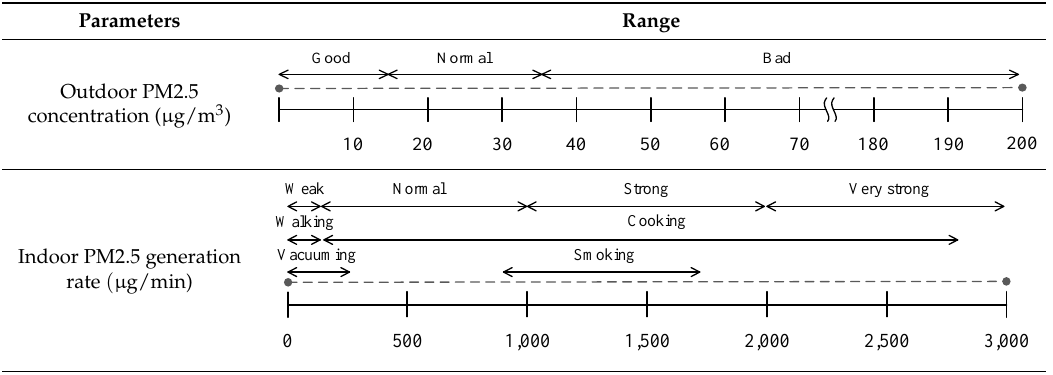
Table 6. Evaluation ranges of outdoor PM2.5 concentration and indoor PM2.5 generation rate.